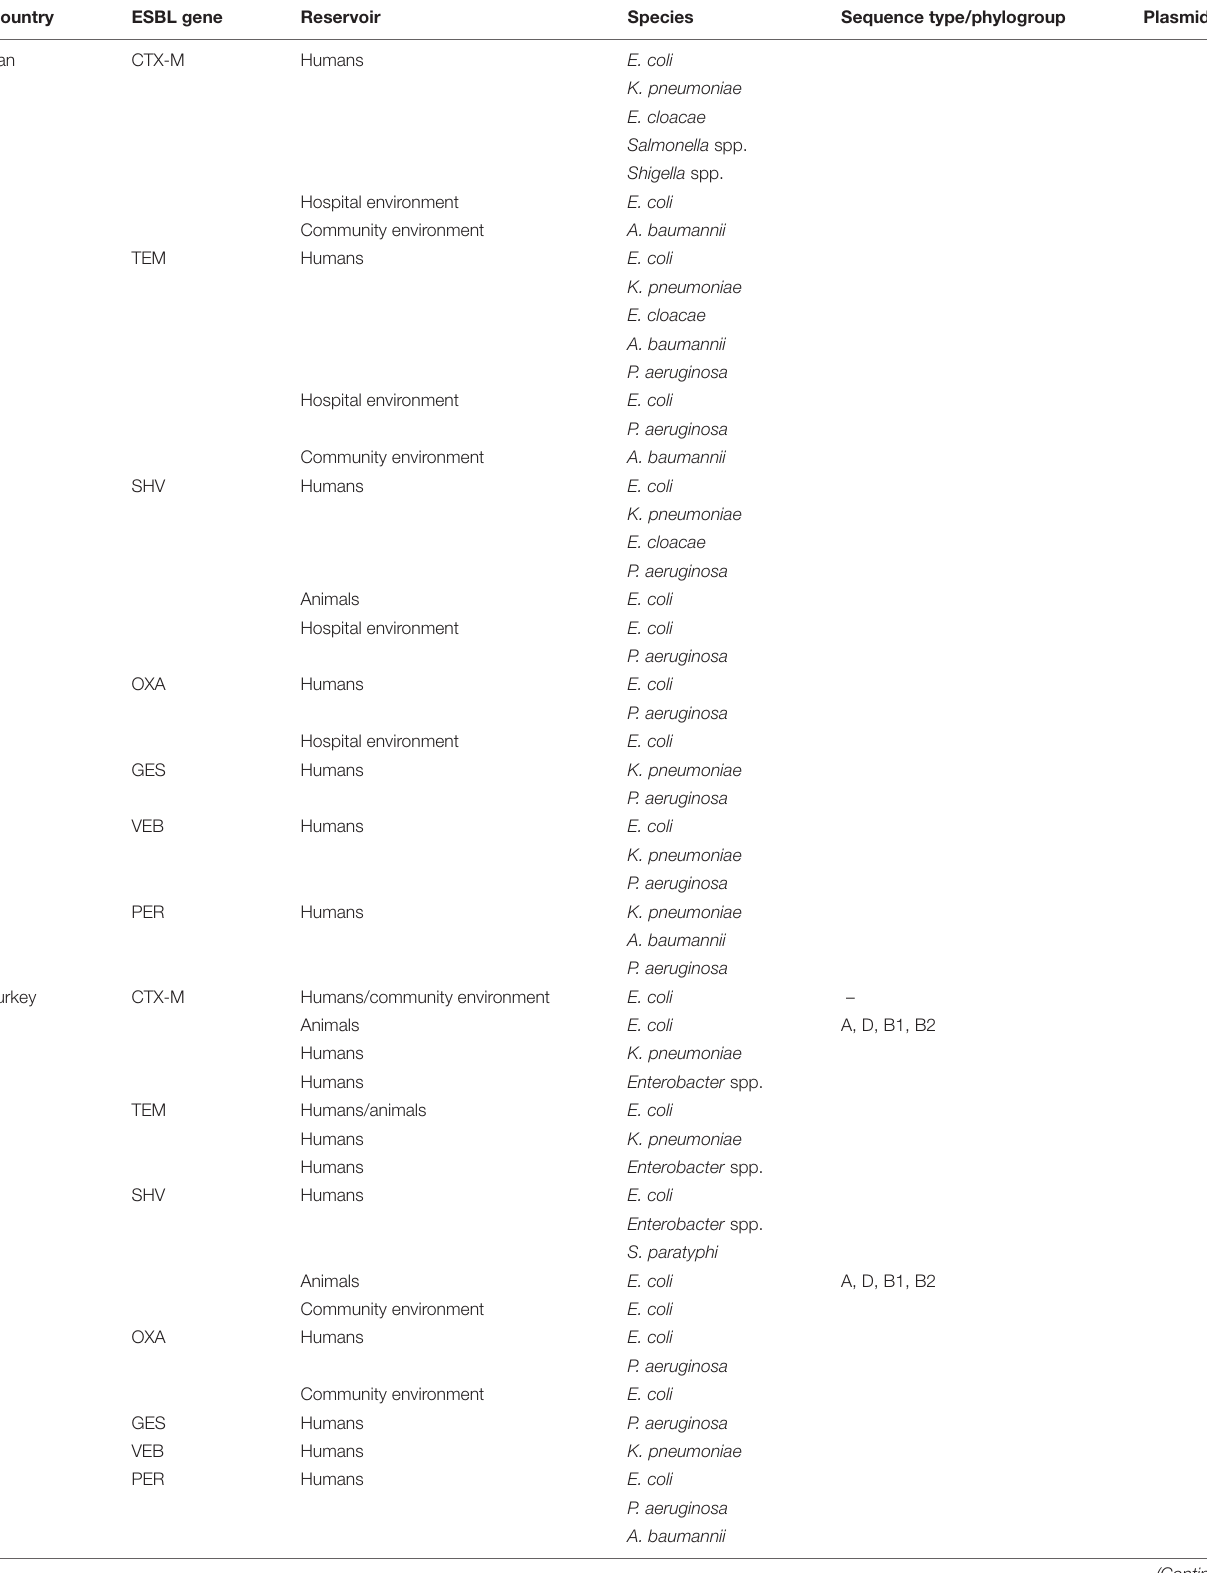
TABLE 1 | Sequence and plasmid types associated with ESBL genes in humans, animals, and environment in the Middle East. Country ESBL gene